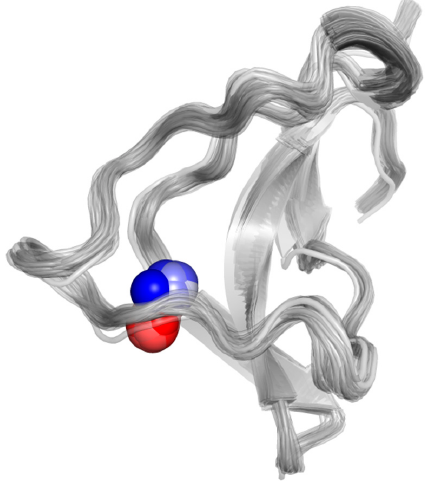
Figure 3. Displacement of the Zn(II) ion towards the solvent bulk along one of the three 30 ps C132A QM/MM MD trajectories. The different positions of the Zn(II) ion are shown with spheres colored from blue (for the position at the beginning of the simulation) to white, to red (at the end of the simulation). Equivalent figures for the other mutant trajectories are given in the Figure S1.